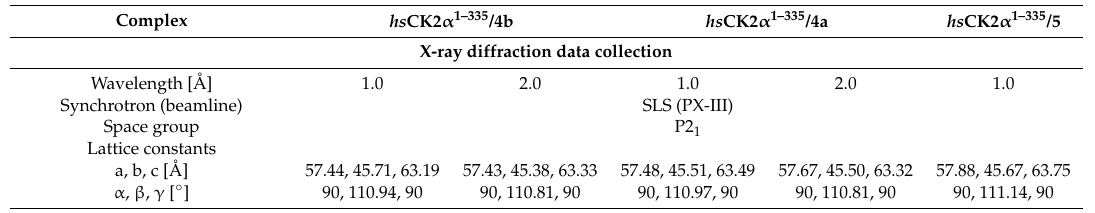
Table 3. X-ray diffraction data collection and refinement